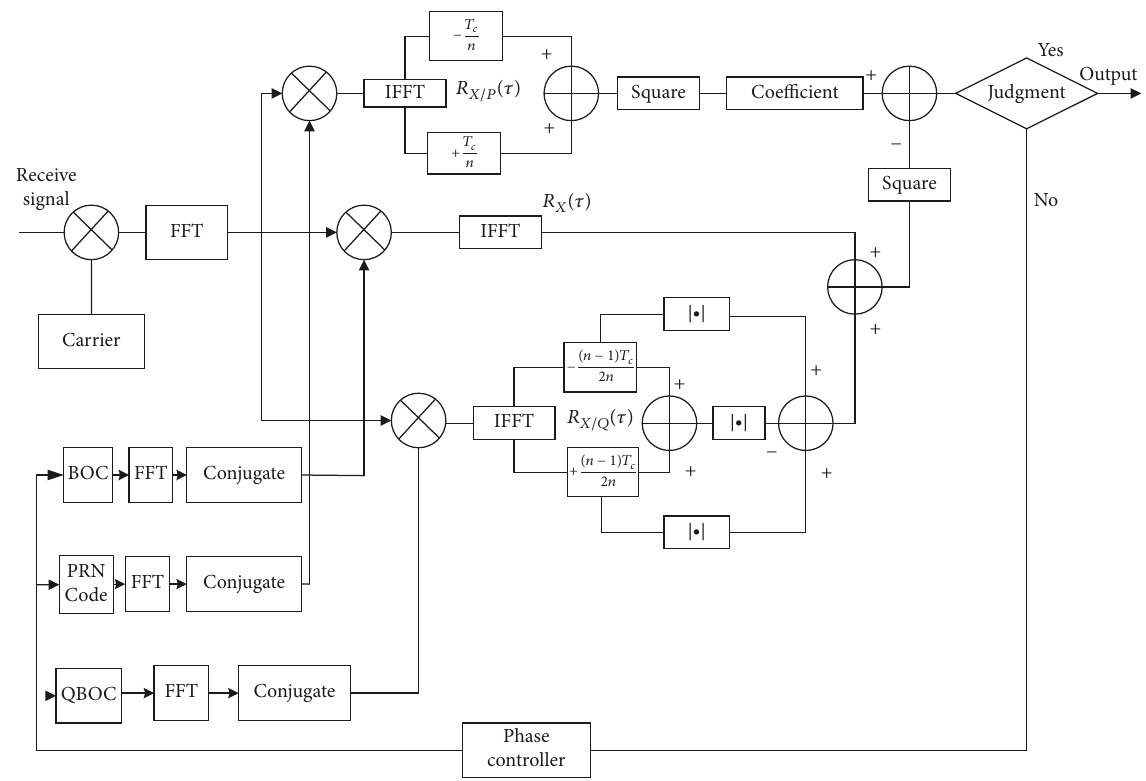
Figure 1: The principle of